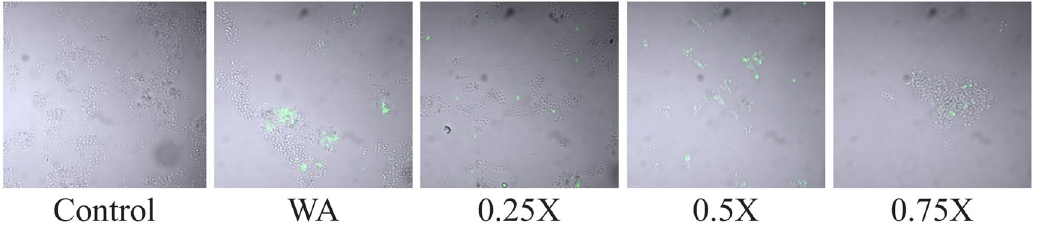
Figure 4. Effect of the supernatants from C29 obtained without stimulus or with ampicillin stimulus at 0.25×, 0.5×, and 0.75× MIC on 1390R. Confocal microscopy analysis was performed. The 1390R was stimulated with the supernatant of C29 produced in the absence of ampicillin and with 0.25×, 0.5×, and 0.75× MIC.